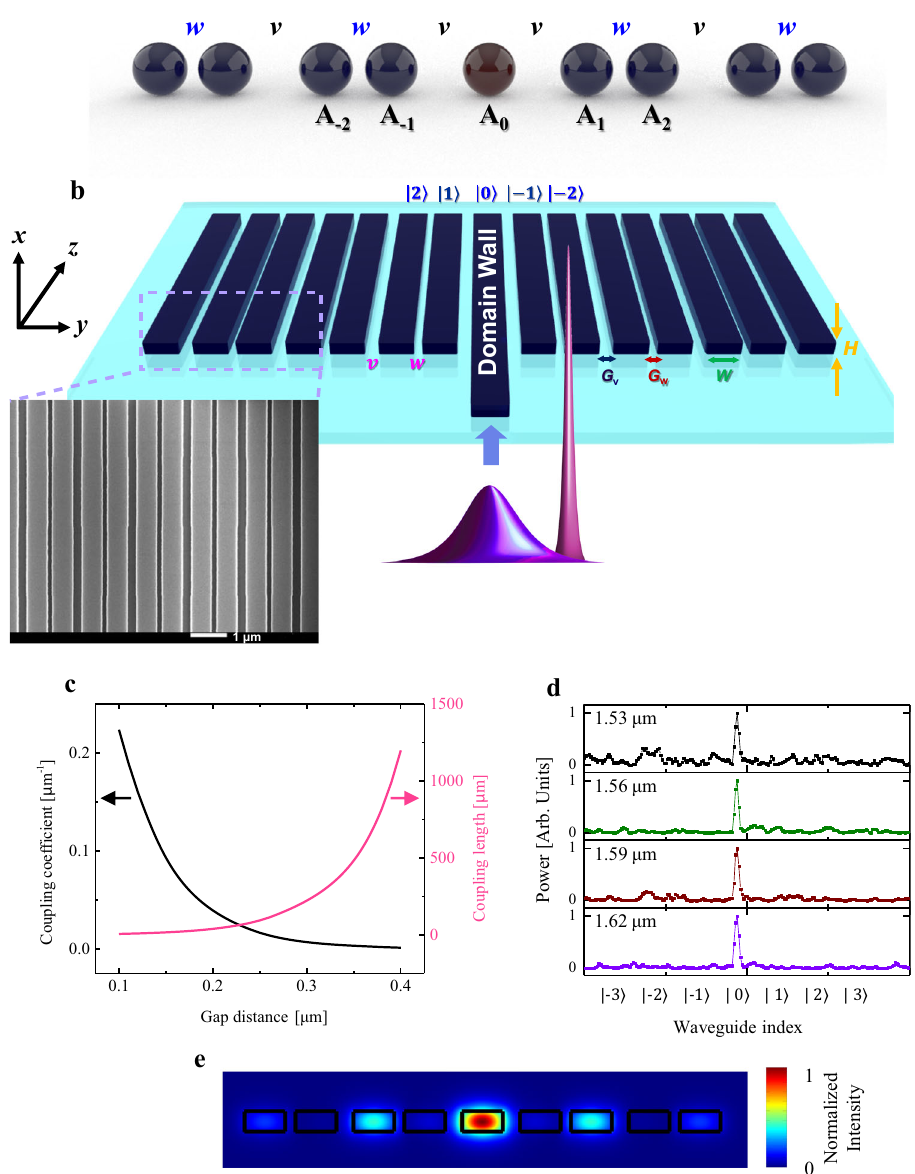
d Measured output powers versus waveguide index positions at diverse wave- lengths from 1.53 to 1.62 µ m. The output power is observed to be well localized at theboundarywaveguideindexedtobe|0 〉 . e Topologicalmodepro fi lenumerically calculated using the fi nite-element method. It is observed that the mode is